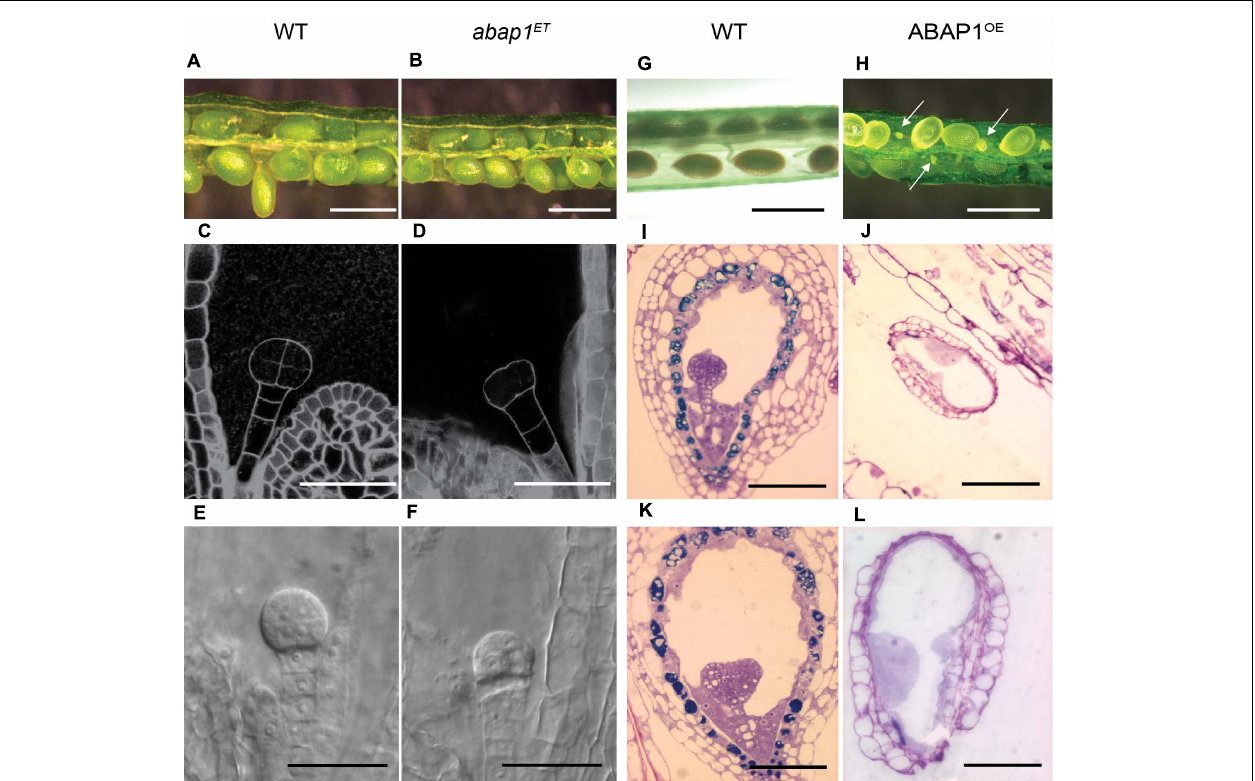
FIGURE 1 | Embryo development in plants with altered levels of ABAP1. Images of siliques at the same developmental stages, comparing embryo and seed development in wild-type (WT) and mutant plants. Left panels (A–F) shows comparison between WT and abap1 ET plants. (A,B) Open siliques of WT and abap1 ET plants showing normal seed size. (C–F) Initial events in embryo development from WT and abap1 ET seeds. Dark field illumination microscopy of WT seeds with embryo at 8 cell stage (C) , and abap1 ET seeds with the embryo at the initial zygotic divisions (D) . Nomarski microscopy of embryos from WT plants at globular cell stage (E) and from abap1 ET plants with defects after the initial zygotic divisions (F) . Right panels (G–L) shows comparisons between WT and ABAP1 OE plants. (G) Open WT siliques with normal developing seeds; and (H) open ABAP1 OE siliques with small and shriveled seeds (arrows). (I,K) Micrographs of sections of WT seeds with embryos at globular (I) and transition to early heart stages (K) . (J,L) Micrographs of sections of ABAP1 OE seeds that did not develop and/or arrested before fertilization (J) . (L) is a higher magnification of (J) . Scale bars: 1 mm in (A,B,G,H) ; 20 µ m in (C–F) ; 100 µ m in (I–K) ; and 50 µ m in (L) . For abap1 ET and WT Landsberg erecta background plants, a total of 300 seeds in 15 siliques were analyzed for each genotype. For ABAP1 OE a total of 708 seeds were analyzed in 36 siliques, and for Col-0 WT plants 432 seeds were analyzed in 18 siliques.